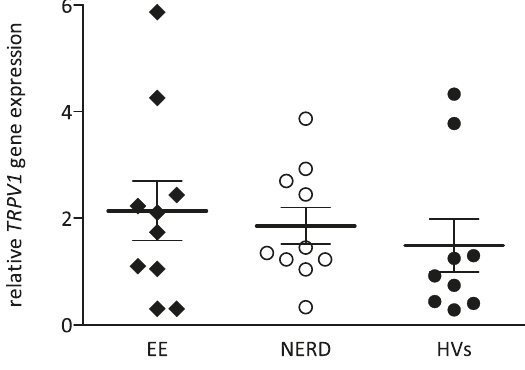
Figure 4. Median TRPV1 gene transcription in patients with EE, NERD and